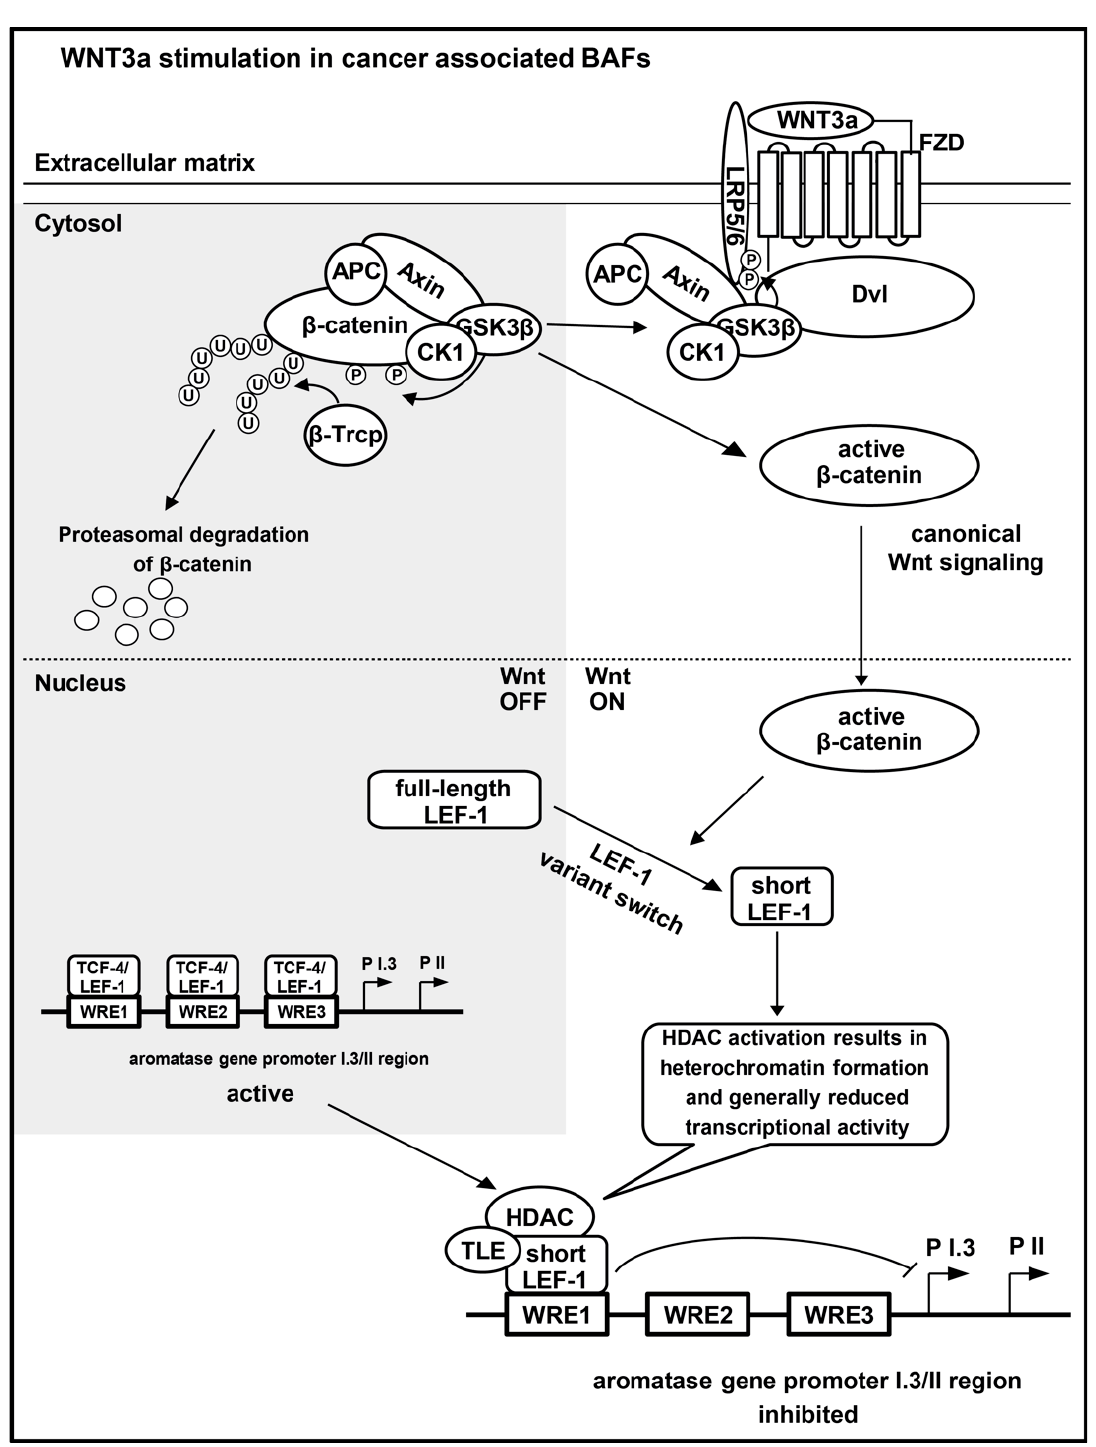
Figure 7. Model for key events in WNT3a-initiated suppression of aromatase expression in BAFs. WNT3a binds Frizzled (FZD) [51], in association with the co-receptor low-density lipoprotein receptor-related protein 5 or 6 (LRP5/6) [52]. In consequence, the β -catenin degradation complex (axin, adenomatous polyposis coli (APC), glycogen synthase kinase 3- β (GSK-3 β ) and casein kinase 1